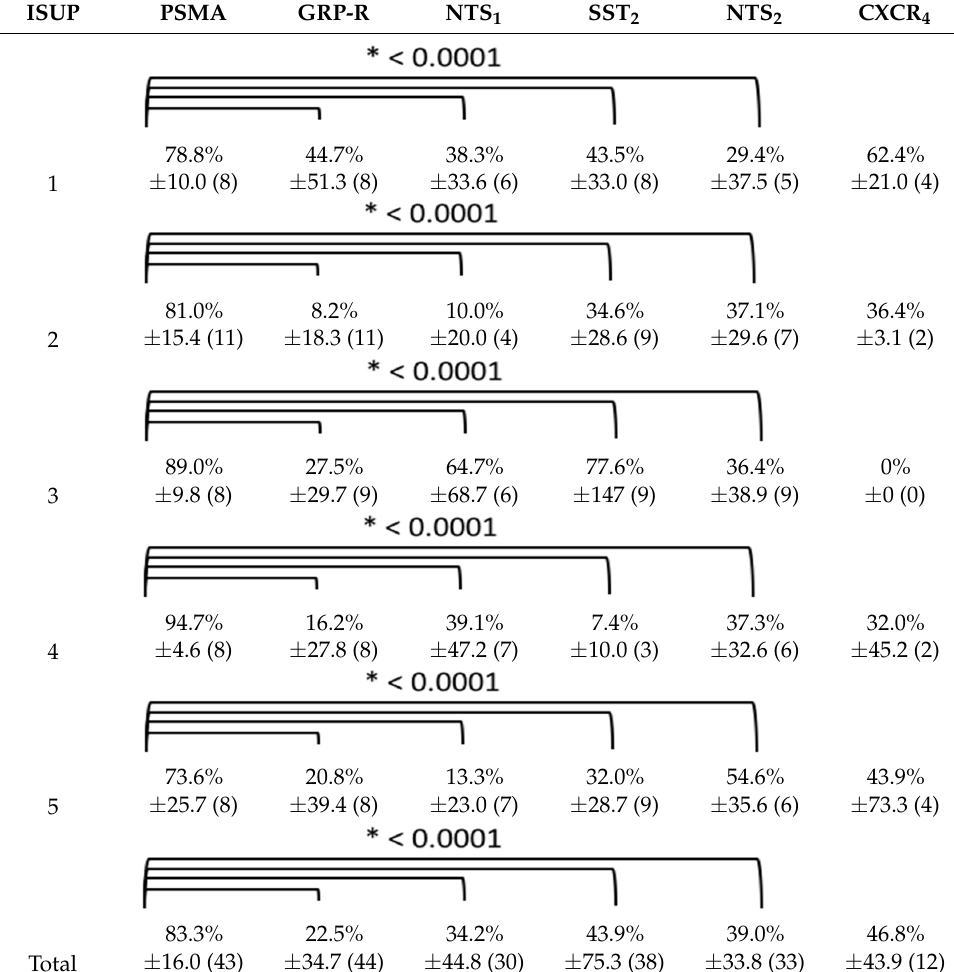
Table 4. Number of Delta ≥ PSMA for GRP-R, NTS 1 , SST 2 , NTS 2 and CXCR 4 . Note: ISUP5 NTS 2 >> PSMA (95% vs. 44%).